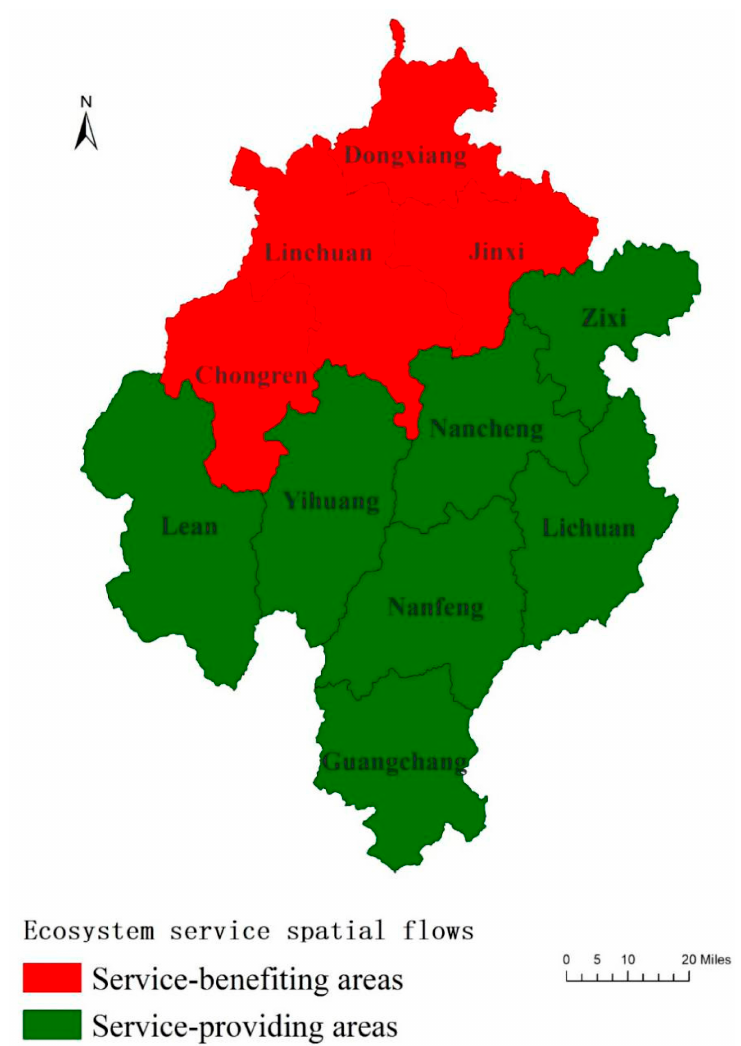
Figure 3. Identification of service-benefiting areas and service-providing areas. Districts or counties reflects the spatial direction of the ecosystem service